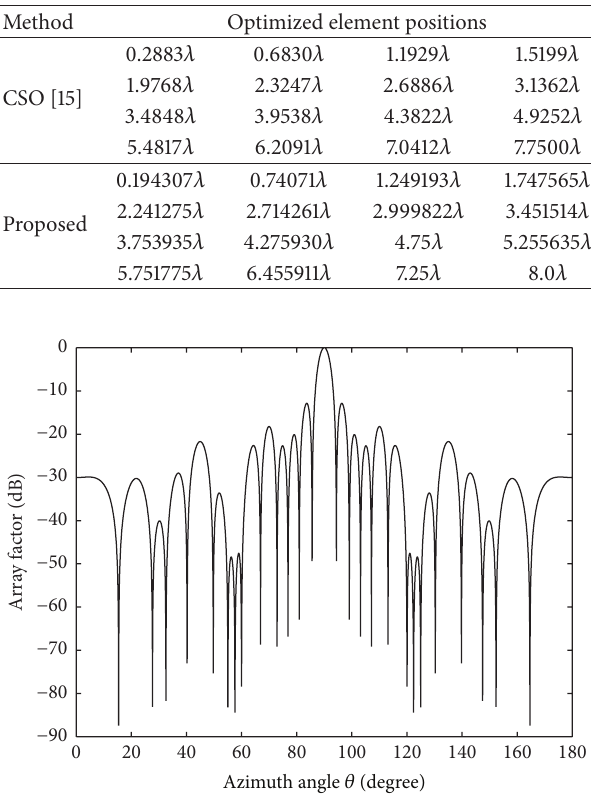
Table 6: Optimized positions of the positive half of the 32-element array of Example 3 .